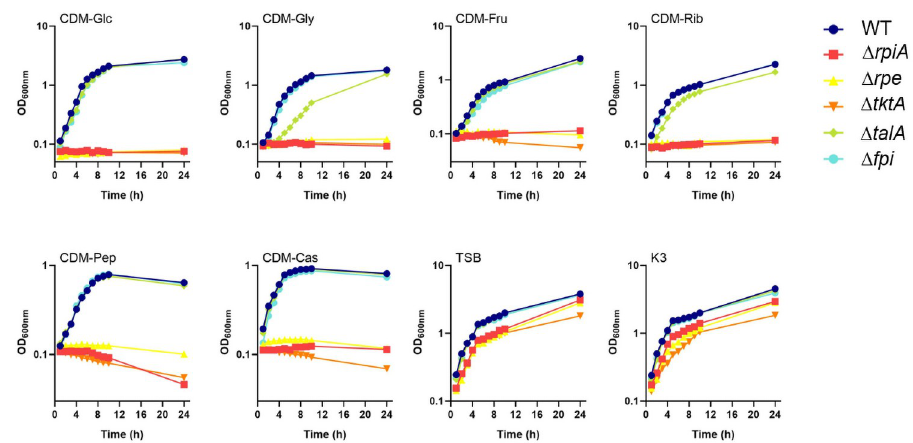
Fig 2. Growth of the PPP mutants in liquid culture. Bacterial growth was monitored in CDM supplemented with various carbon sources: Glc (glucose), Gly (glycerol), Rib (ribose) and Fru (fructose), at a final concentration of 25 mM; or Cas (casamino acids), and Pep (peptone) at a final concentration of 0.2%. Bacterial growth was also monitored in two complex media: TSB (trypic soya broth) and K3 (Shaedler K3 medium). Stationary-phase bacterial cultures of wild-type F . novicida (WT), Δ tktA , Δ rpE , Δ rpiA , Δ talA and Δ fpi mutants were diluted to a final OD 600nm of 0.1, in 20 mL broth. Every hour, the OD 600nm of the culture was measured, during a 24 h-period.